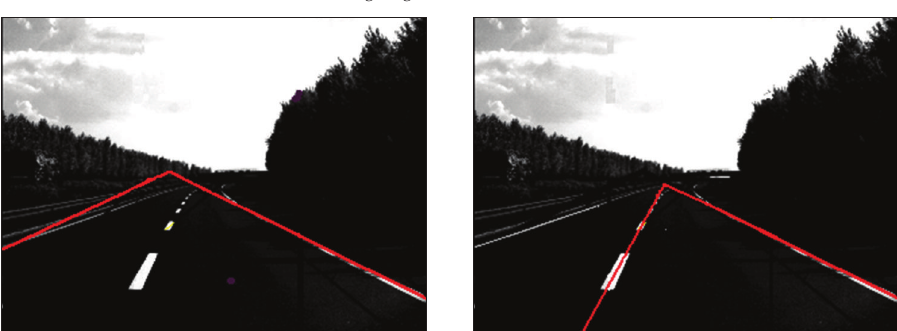
Figure 10: Some typical experimental